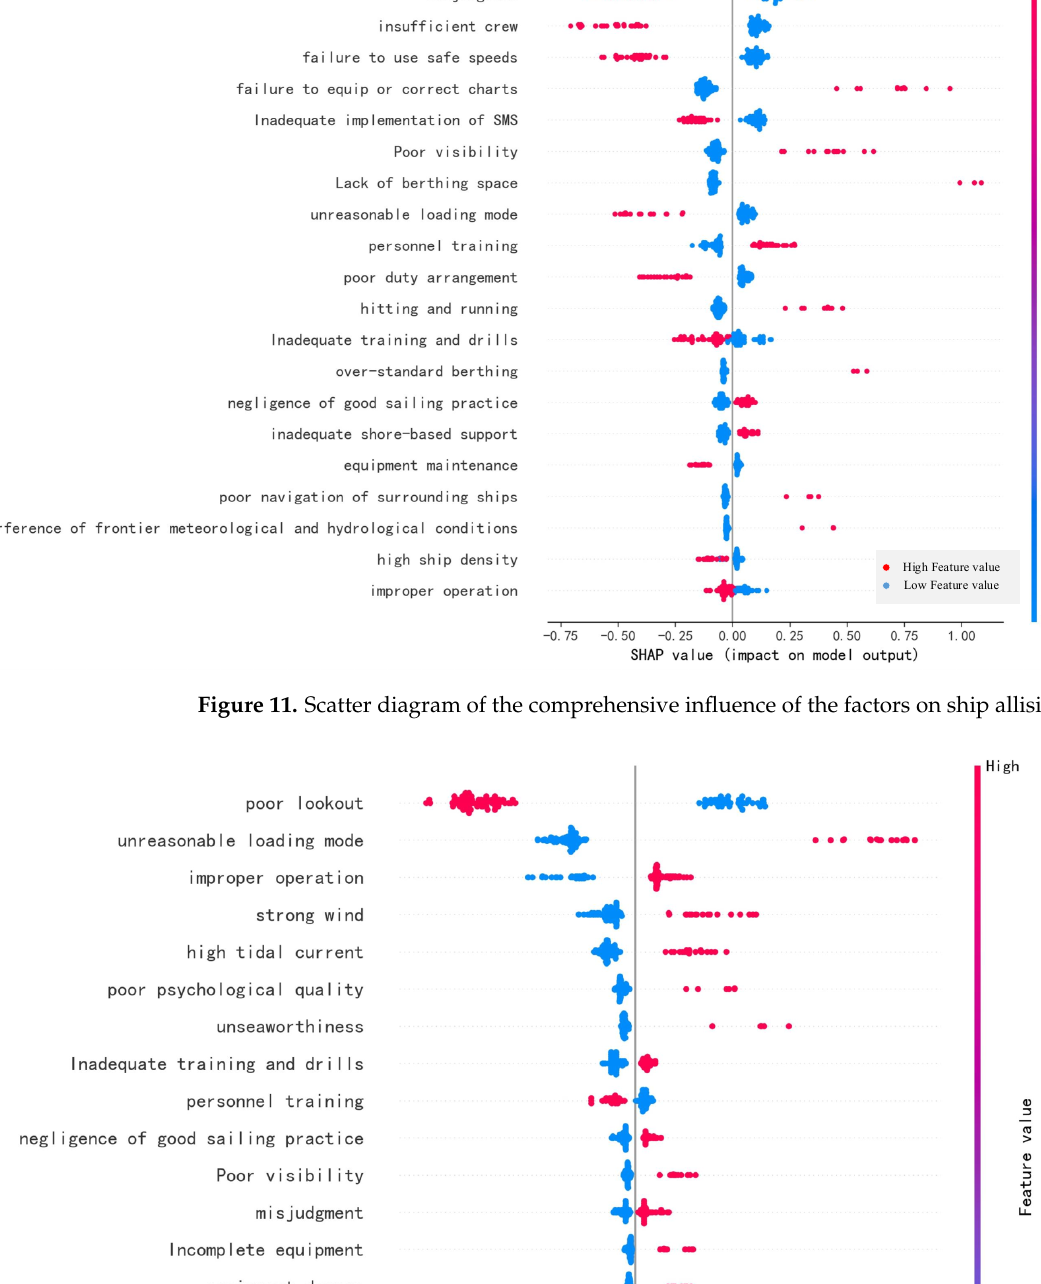
Figure 10. Scatter diagram of the comprehensive influence of the factors on ship collisions.